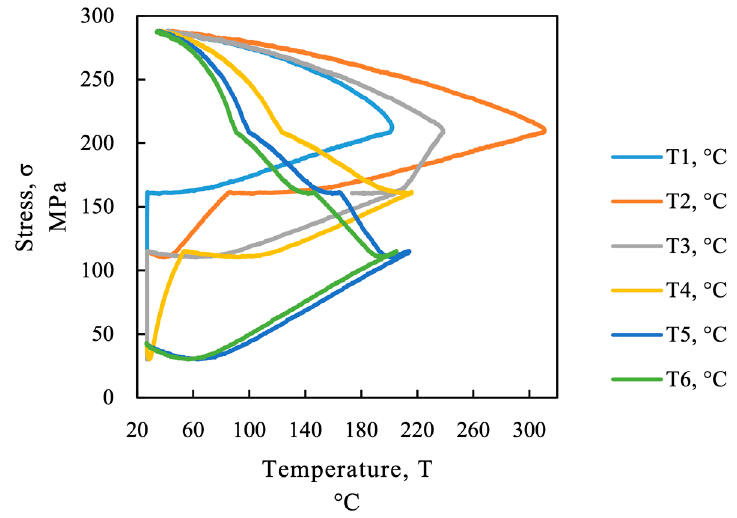
Figure 13. Temperature stress relationship at the SMA strip; beam SMA_1.